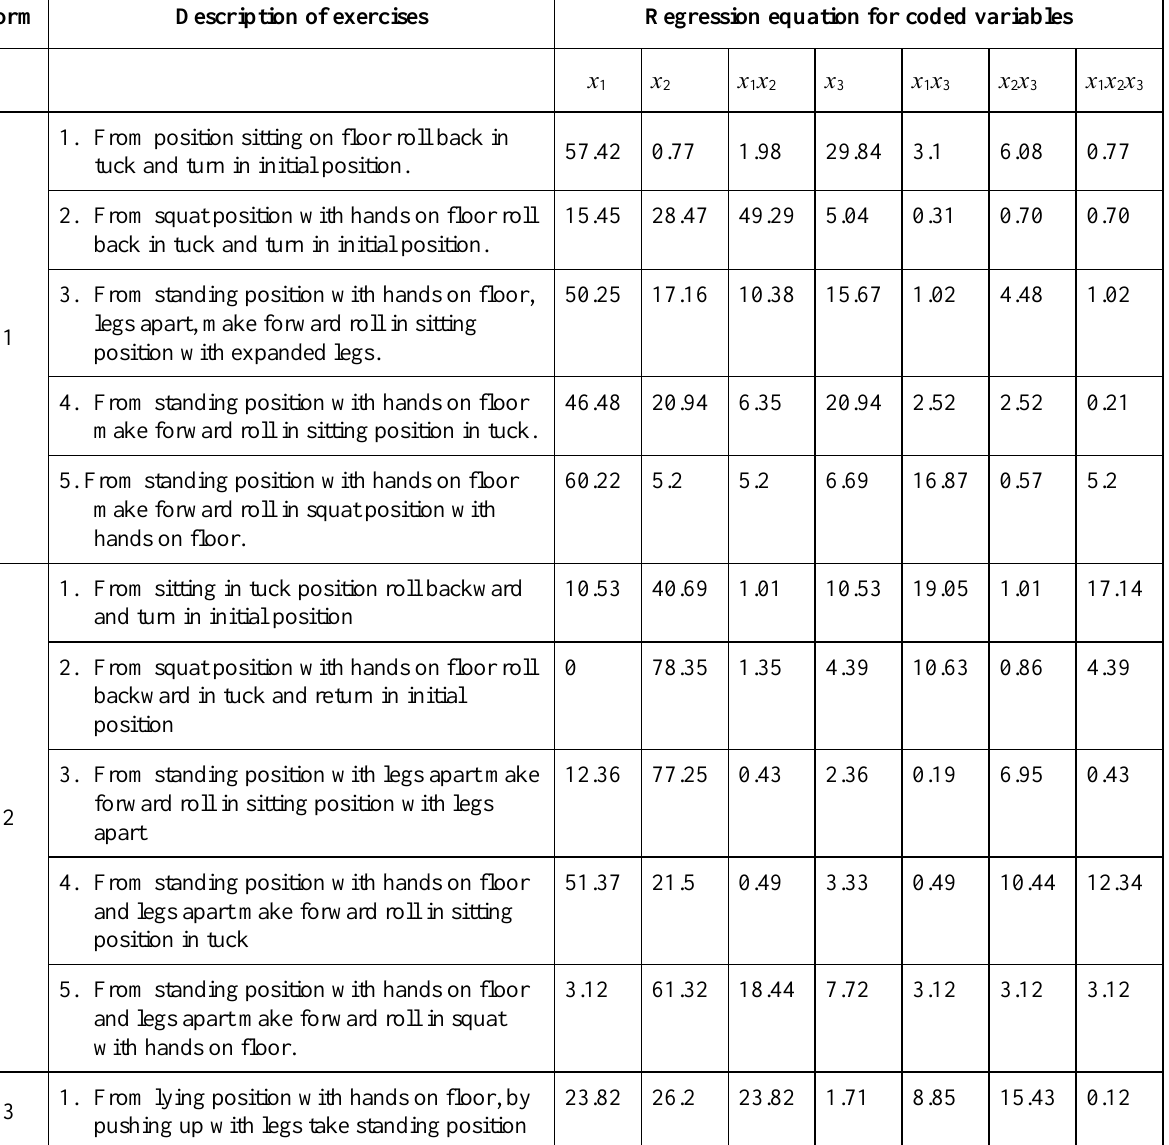
Results of dispersion analysis for FFE 23, which studies dependence of increment of gymnastic exercises mastering on quantity of attempts (х 1 ), quantity of repetitions in one attempt (х 2 ) and rest intervals (х 3 ) of 1-4 form pupils Form Description of exercises Regression equation for coded